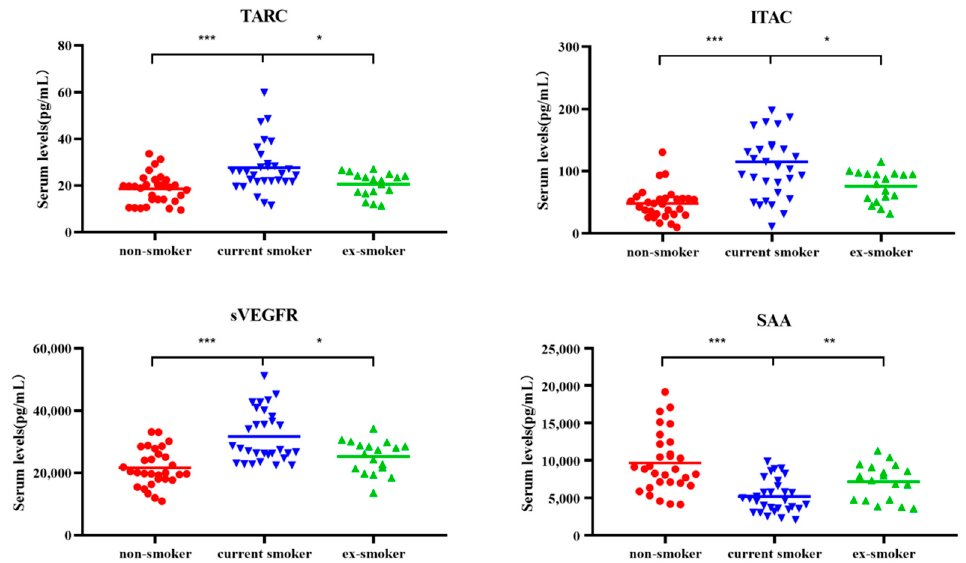
Figure 2. Scatter plots of serum levels (pg/mL) of cytokines TARC, ITAC, sVEGFR3, and SAA for non-smokers ( n = 30), current smokers ( n = 30), and ex-smokers ( n = 18). Whiskers calculated using the Tukey method. Outliers not shown. * p < 0.05, ** p < 0.01, *** p < 0.001: Kruskal–Wallis test and Dunn’s multiple comparison test.